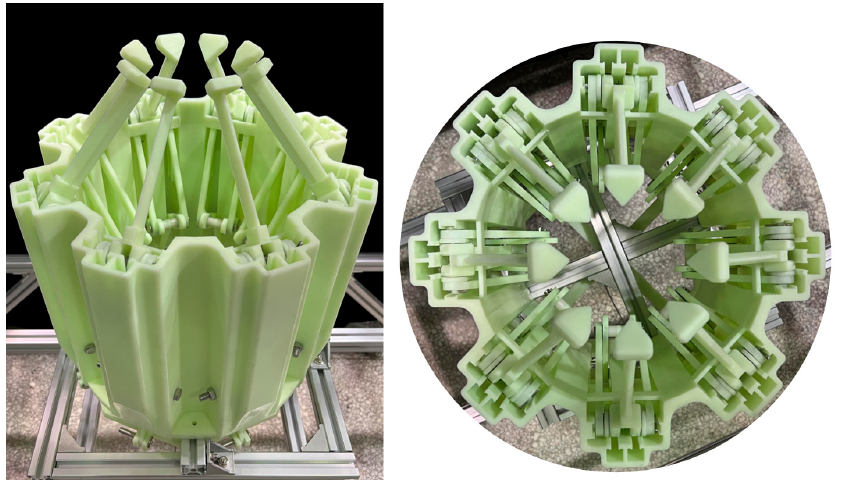
Remote Sens. 2022 , 14 , x FOR PEER REVIEW 17 of 20 Figure 16. Active part of the deployable docking mechanism. Figure 16. Active part of the deployable docking mechanism.